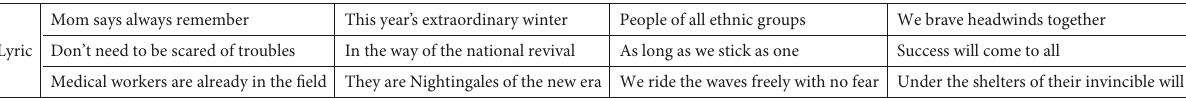
TABLE 2 The music China Braves Headwind.